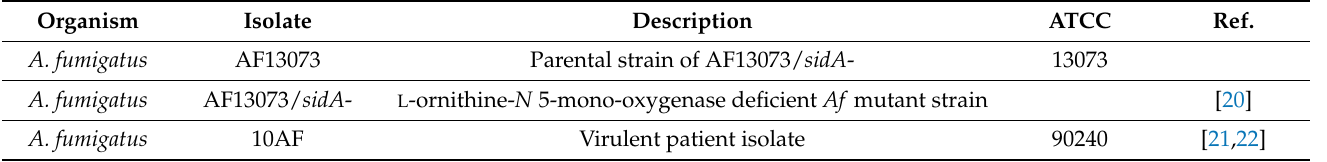
Table 1. A. fumigatus strains and isolates used in this